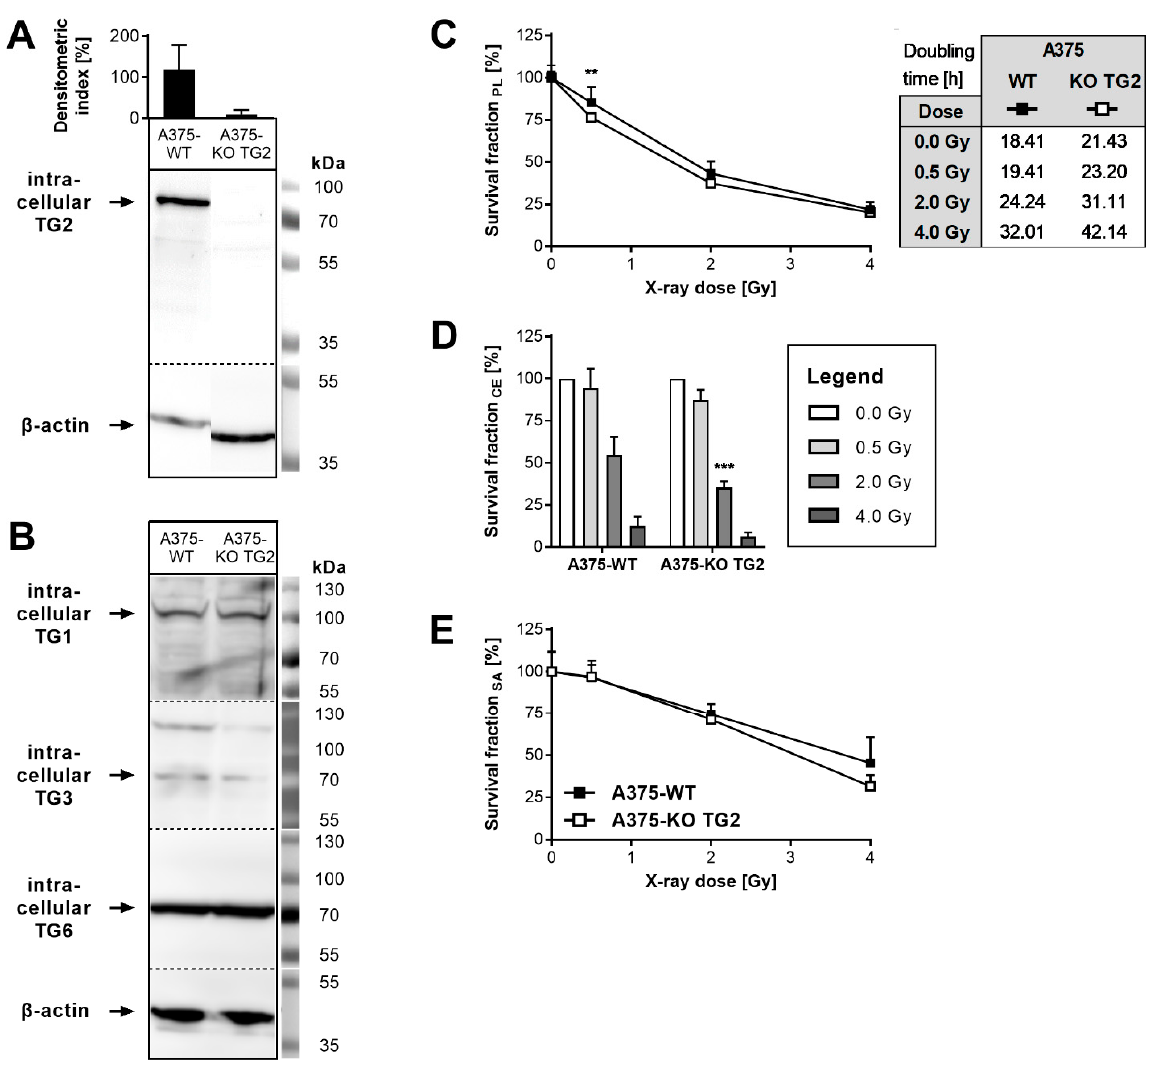
Figure 3. Effects of TG2 knock-out in A375-WT cells on cellular reaction towards irradiation. ( A ) TG2 KO in A375-WT cells was verified via Western blot using cell lysates and semi-quantitative densitometric analysis. Densitometric indices were calculated by normalization to ß-actin biosynthesis values. ( B ) Biosynthesis of TG1, TG3 and TG6 in A375-WT and -KO TG2 cells. ß-actin biosynthesis was employed as a loading control. ( C ) Proliferation (PL) of A375-WT and A375-KO TG2 cells 72 h after irradiation. Survival fractions were calculated from cell counts normalized to non-irradiated (0 Gy) mean values of each cell line. Doubling times (h) over 72 h are indicated in the table. ( D ) Clonal expansion (CE) of A375-WT and A375-KO TG2 cells after irradiation. Survival fractions resulted from plating efficiencies normalized to non-irradiated (0 Gy) values of each cell line. ( E ) Spheroidal areas (SA) were determined at day 14 after irradiation and normalized to respective non-irradiated (0 Gy) mean values. Mean values ± SD ( n ≥ 4, except of biosynthesis of A375-KO TG2 ( n = 2)) and representative blots are shown. Significant variances are displayed as ** (KO TG2 vs. WT, p ≤ 0.01) and *** (KO TG2 vs. WT, p ≤